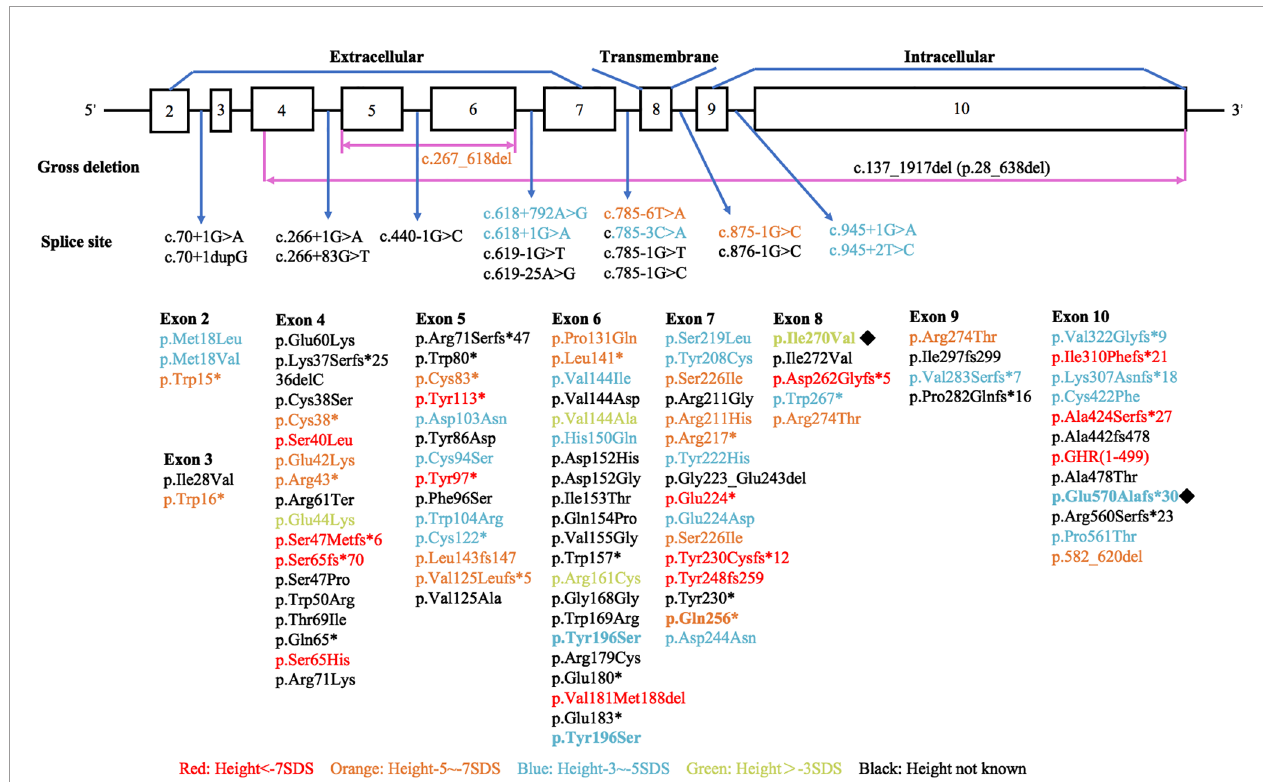
FIGURE 6 | Diagrammatic representation of the human GHR gene mutations published in patients with Laron syndrome. Different colors stand for variant severity of height defect. Red stands for patients with height less than -7 SDS, orange stands for patients with height between -5 SDS to -7 SDS, blue stands for patients with height between -3 SDS to -5 SDS, and green stands for patients with height above -3 SDS. Novel mutations found in our present study were labeled with ◆